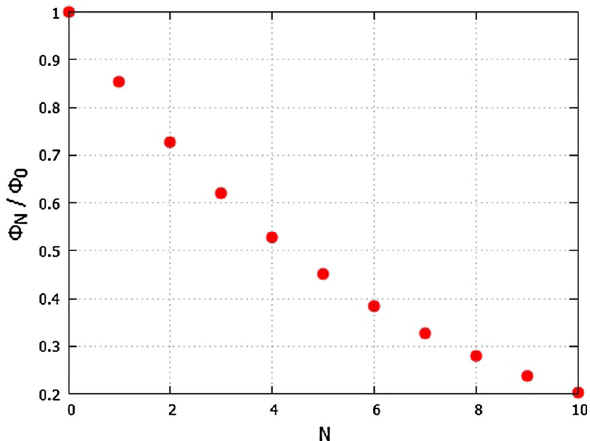
Fig. 2 Evolution of the ratio φ N /φ 0 with the number of origin cross- ings N , where φ 0 is the initial oscillation amplitude